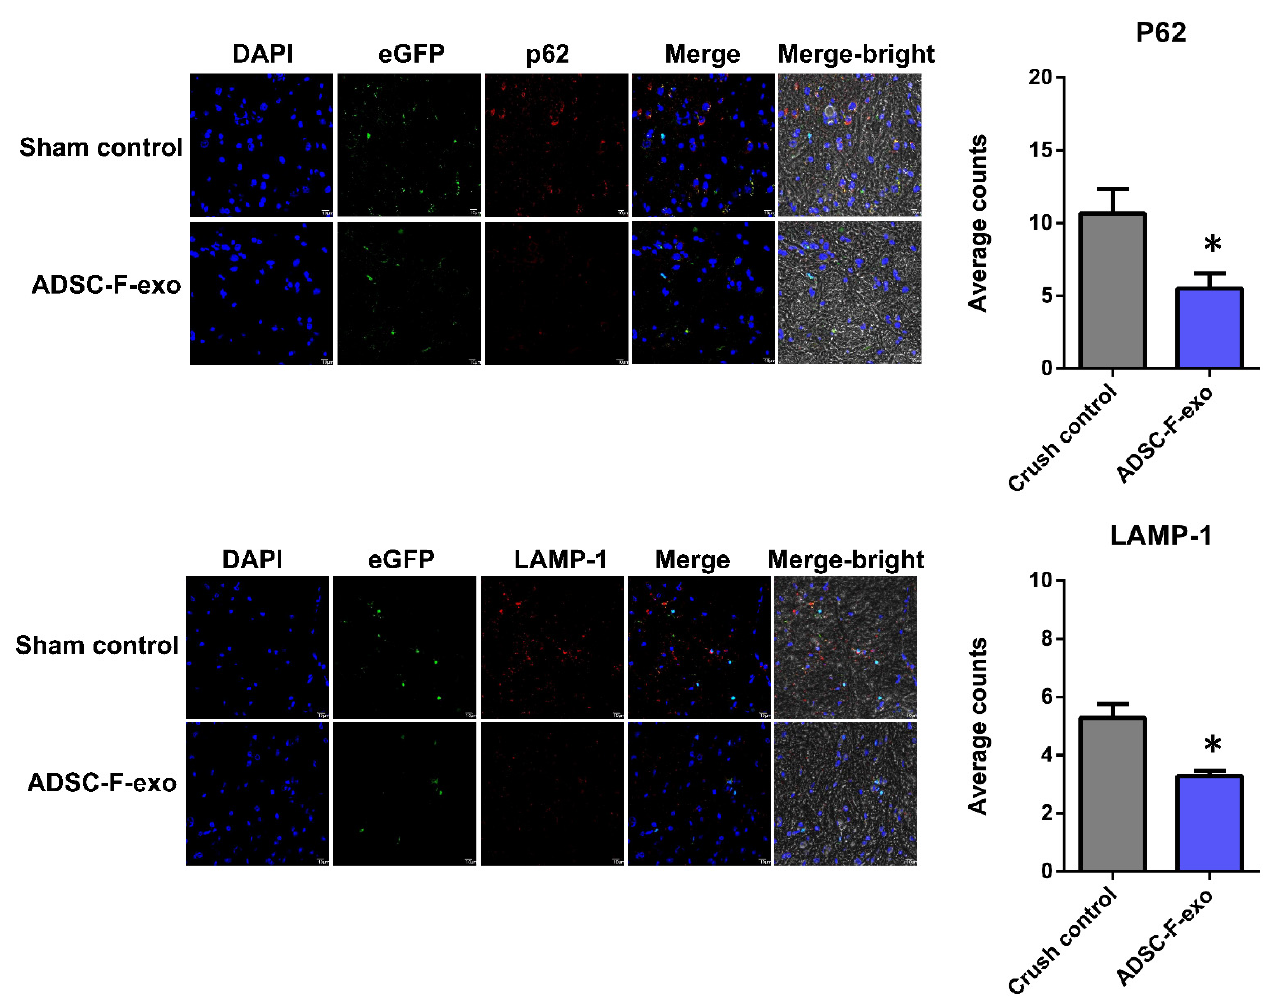
Figure 4. Immunohistochemistry depicting the co-localization of DAPI, eGFP, and the autophagy-related markers (LC3, p62, or LAMP-1) in the spinal segment of L4–6 of MaFIA mice in the absence (crush control) and presence of ADSC-F-exo treatment. * Indicates a significant change ( p < 0.05) when compared to those in the crush control ( n = 6). The error bar represents the standard error of mean.